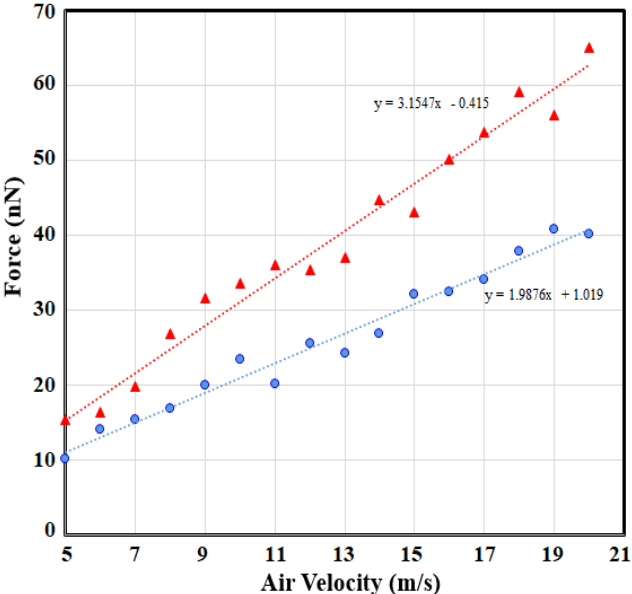
Figure 14. Force generated on MCL1 with L = 400 µm for two microhole radii of R = 12 µm-Blue and R = 14 µ-Red. The force generated shows approximately a linear dependency on air velocity. This diagram is subsequently used for a calibration curve for testing the MEMS component (here is MCL1). This diagram can assure us assured that for a specific air velocity from a certain vertical distance, there is a certain force on the targeted component.